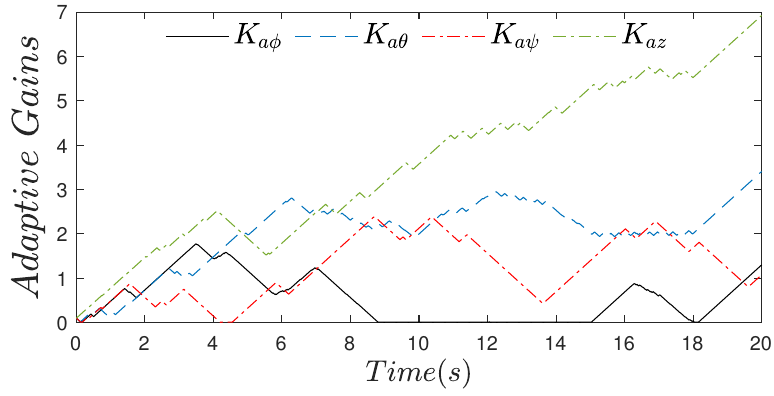
Figure 7. Hovering. Adaptive control